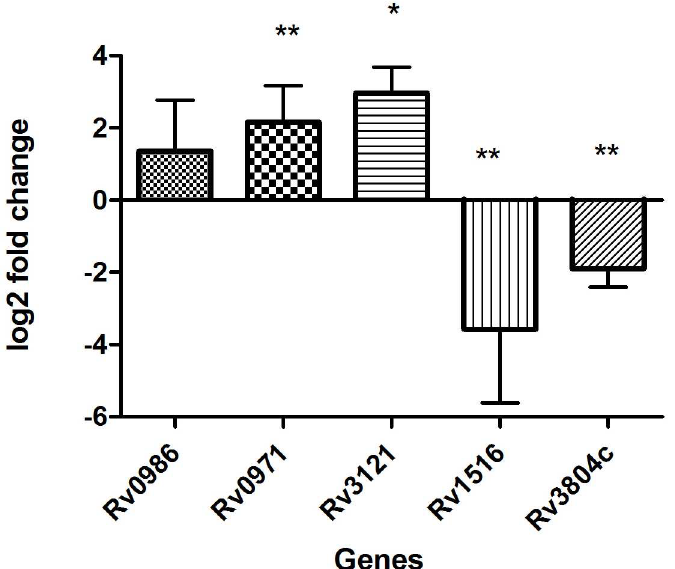
Fig 3. Validation of microarraydata on real time PCR by analyzing the relative expression of 5 genes in smear positive PTB samples as compared to in vitro grown M . tb H37Rv. 16s rRNA was used as reference gene for normalization. Y-axis values (Log2 fold change)of (cid:21) 1 indicateupregulation and values (cid:20) -1 indicatedown-regulation. Each bar represents mean ± SD values for each of the geneswith three technical replicates. * p < 0.05; ** p < 0.01by student’s t